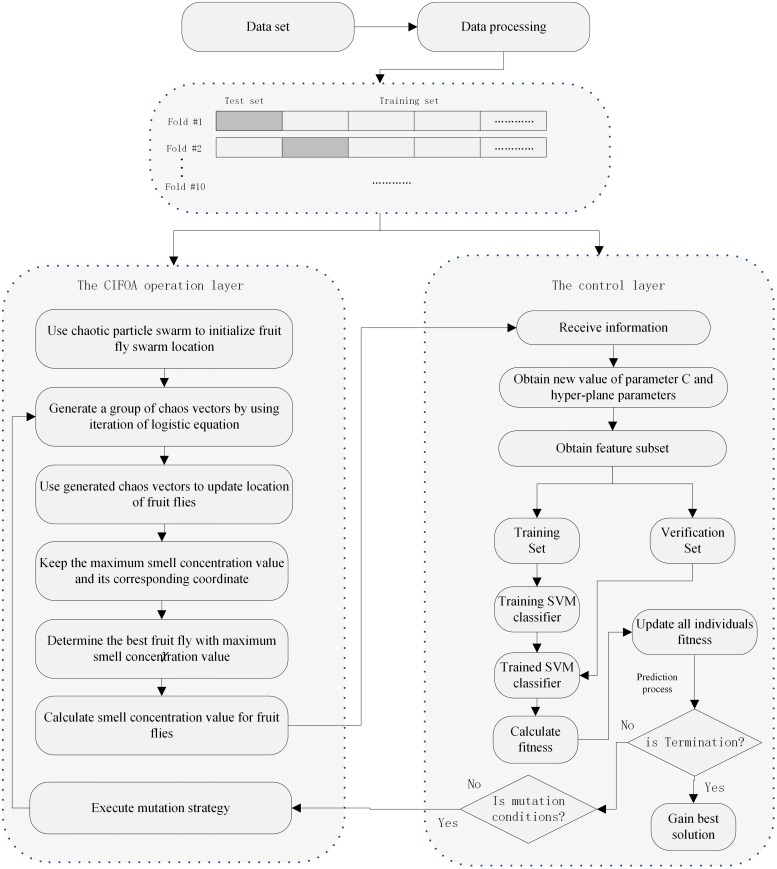
The basic process of the proposed framework.